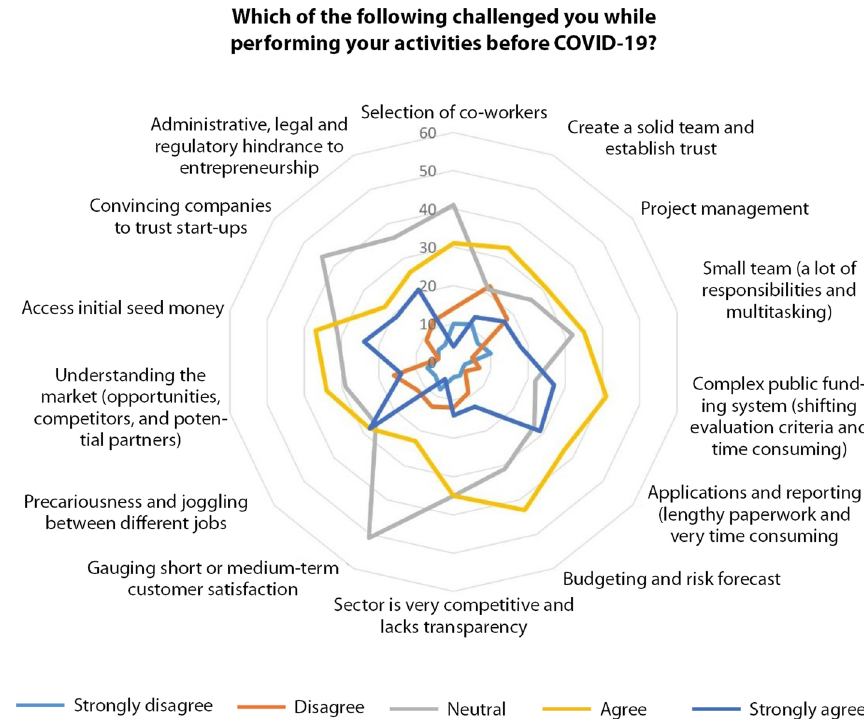
Fig. 13 challenging aspects while performing activities before COVID-19 (Source: the